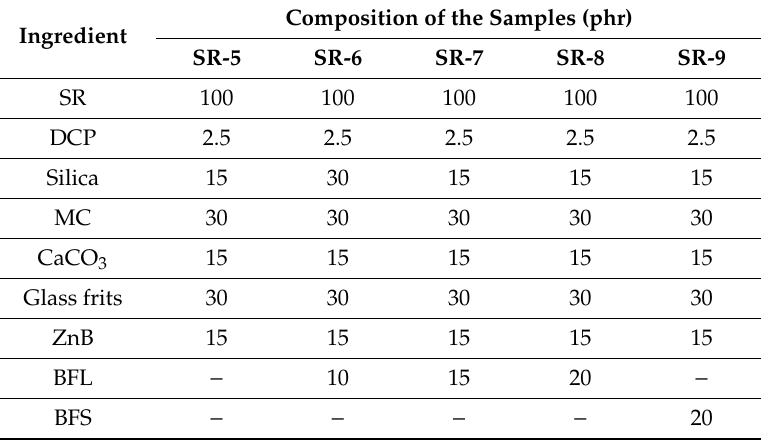
Table 2. Composition (in phr—parts per hundred parts of rubber) of the ceramizable composite mixes. Composition of the Samples (phr) Ingredient